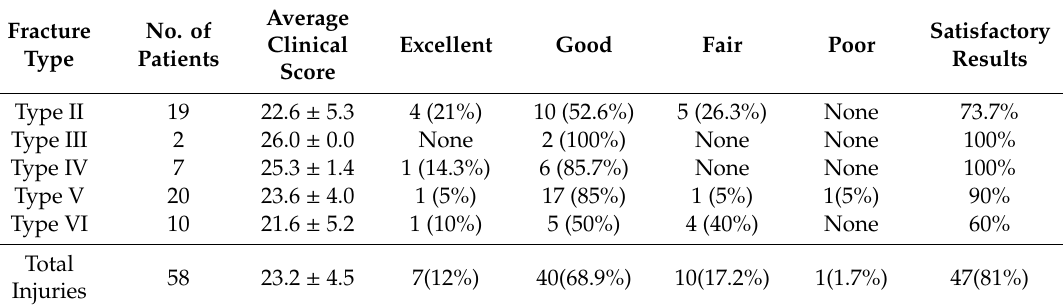
Table 4. Results of clinical assessment in 58